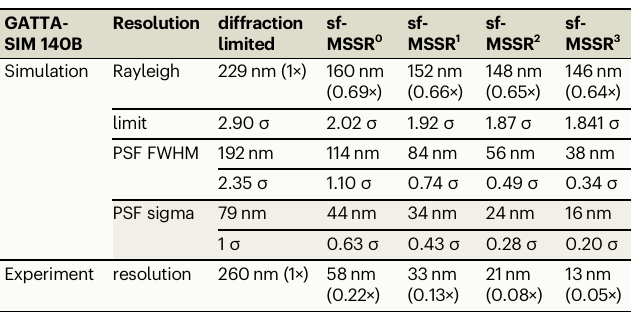
Table 1 | sf-MSSR extends spatial resolution on simulated and real experimental conditions GATTA- SIM